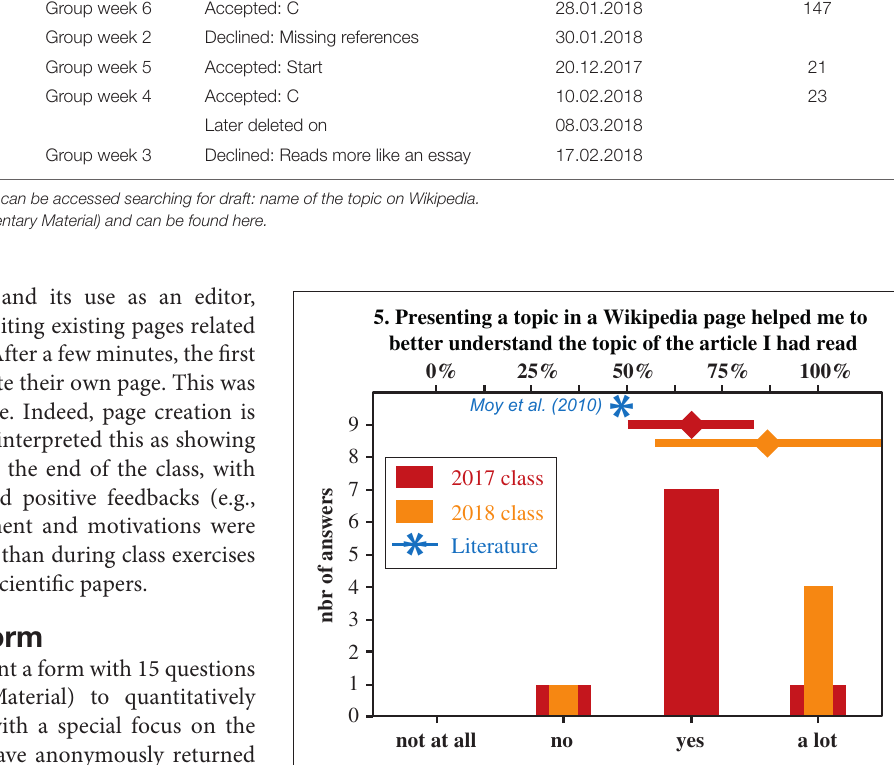
FIGURE 1 | Creation of a Wikipedia page, popularizing scientific data and information, generally helped the students to better understand the topic. However, the amount of learning is bigger while reading the paper, presenting it orally or discussing it in a group. Average (diamond) and one standard deviation (horizontal line) are